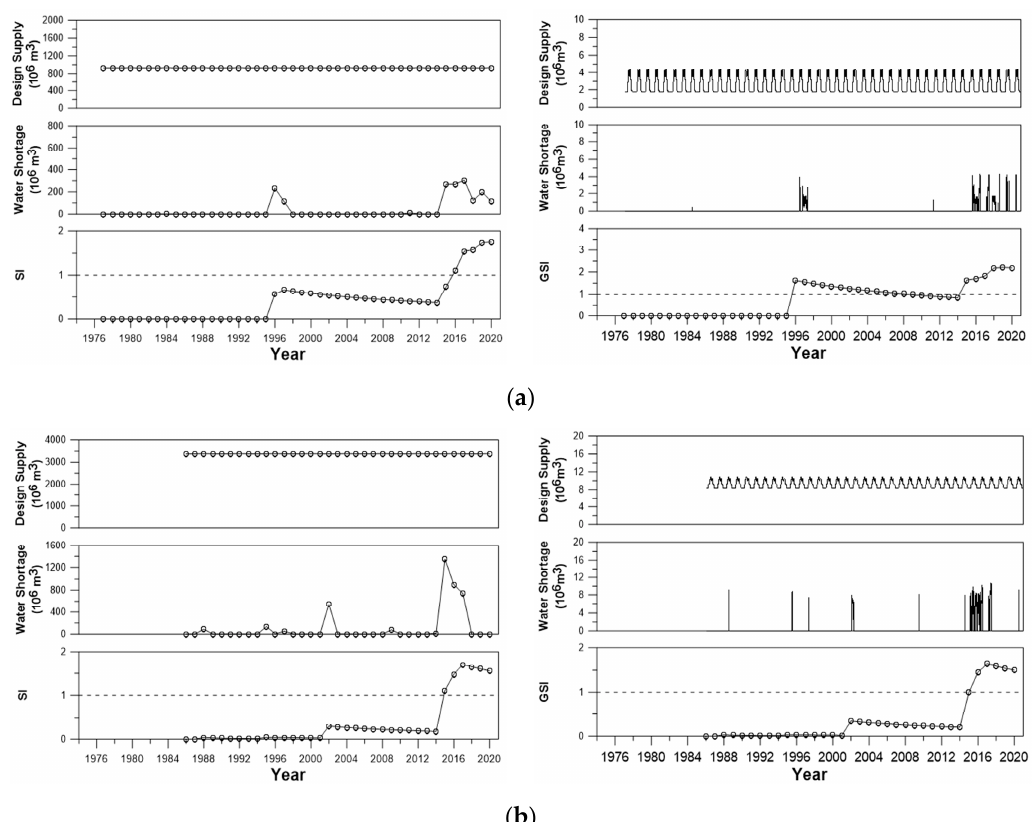
Figure 7. Comparison of estimated SI (left panel) and GSI (right panel) for ( a ) Andong Dam, and ( b ) Chungju Dam.